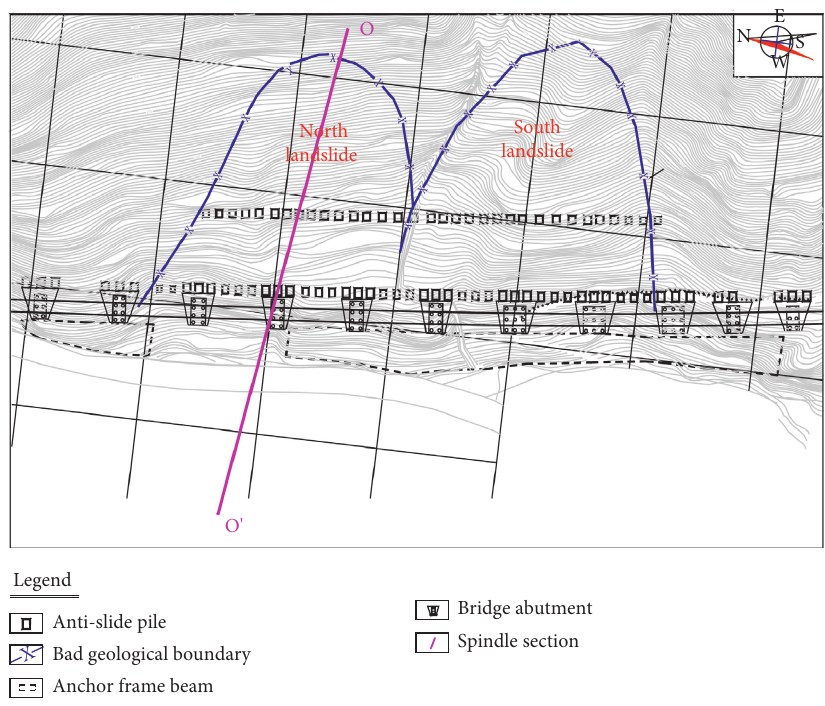
Figure 1: The engineering geological plan of